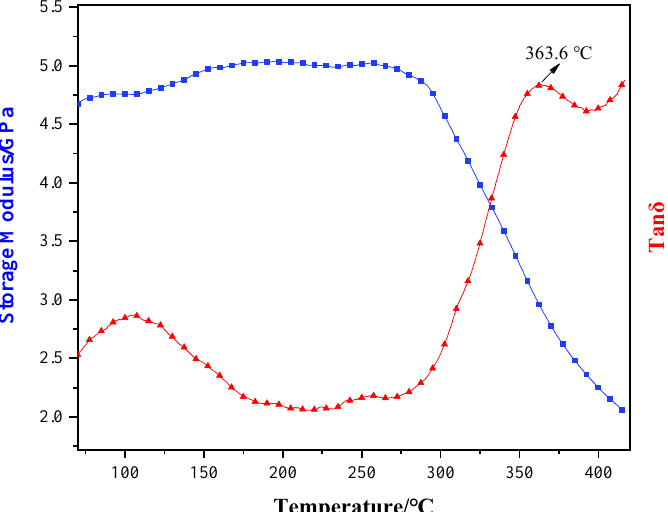
Figure 9. The storage modulus-temperature curve (blue) and the Tanδ-temperature curve (red) of the B 4 C/TiO 2 /polyimide molded plate.